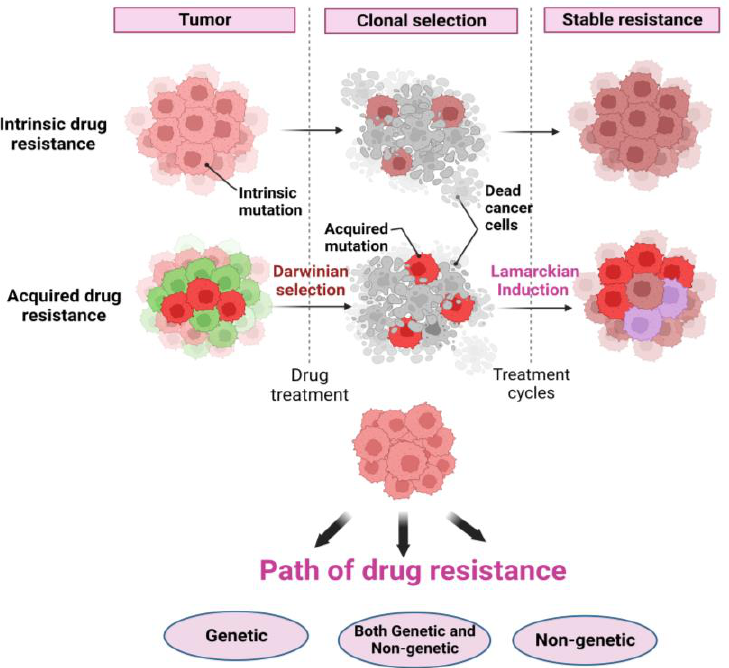
Figure 2. Schematic representation of acquired resistance. Acquired resistance can arise through the Darwinian section or Lamarckian induction. Path of drug resistance where a tumor cell can become resistant purely due to genetic changes through non-genetic alteration in a particular genotype or through initial non-genetic changes combined with genetic mutations.